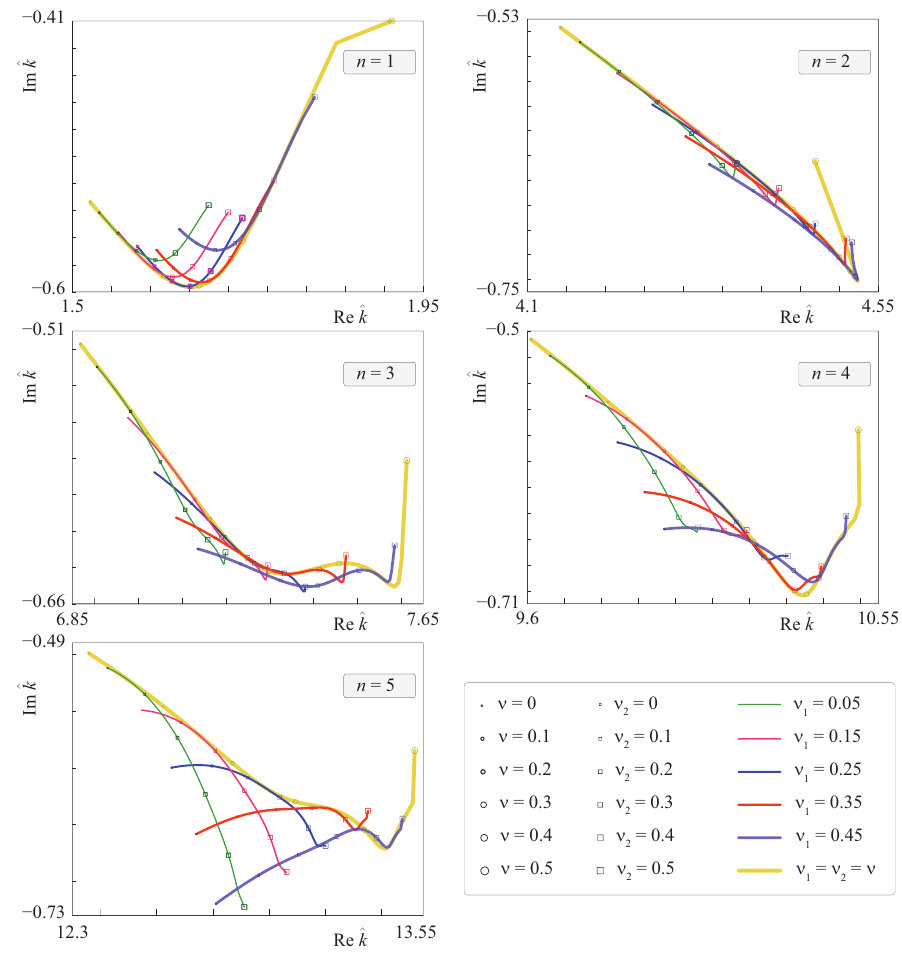
Figure 10. Eigenfrequencies ˆ k 0 n ( ν 1 , ν 2 ) for a circular crack between dissimilar elastic half-spaces; ρ 1 = ρ 2 , µ 1 = µ 2 . Table 4. Eigenfrequencies ˆ k 0 n for open and bridged cracks in a homogeneous space (glass).